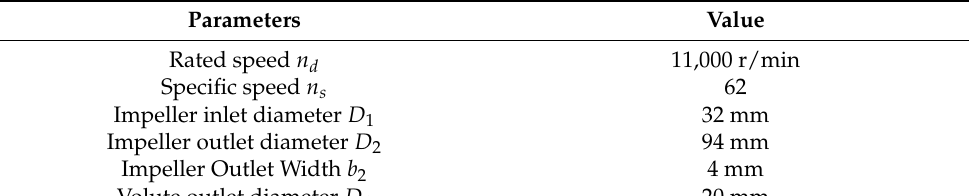
Table 2. The model pump main parameters.